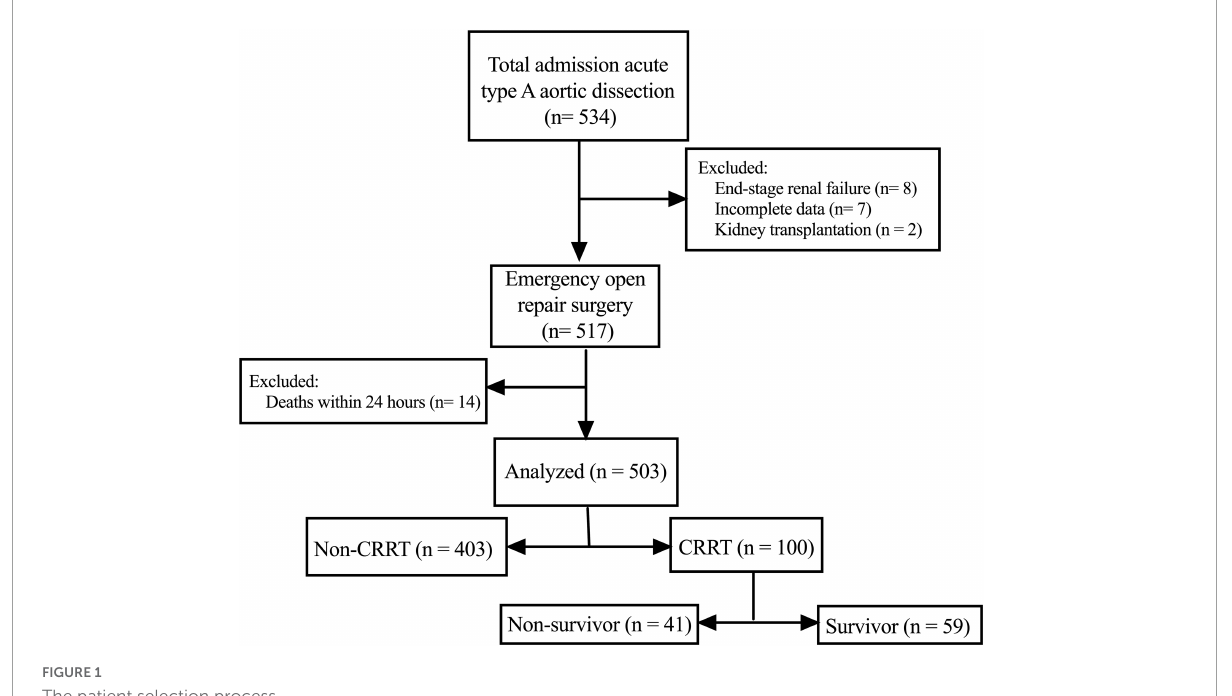
FIGURE1 The patient selection